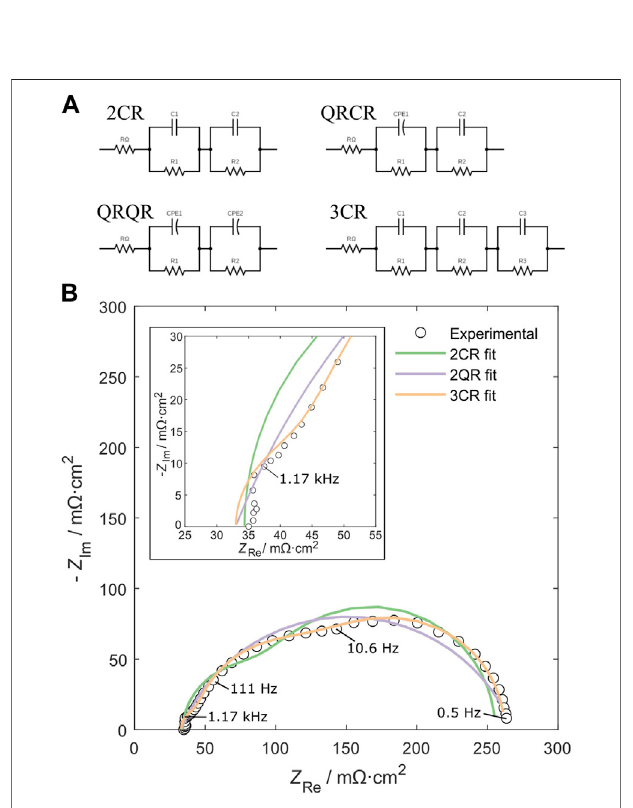
FIGURE1|(A) Selectedequivalentcircuitcandidates identi fi edfrom the literature, and (B) a single-sine Nyquist plot recorded at a current density of 1,000 mA cm − 2 and over a frequency range of 50 kHz to 0.5 Hz. The experimental data is shown as black triangles, with the 2CR, 2QR, and 3CR fi ts represented by the blue, green, and red lines,